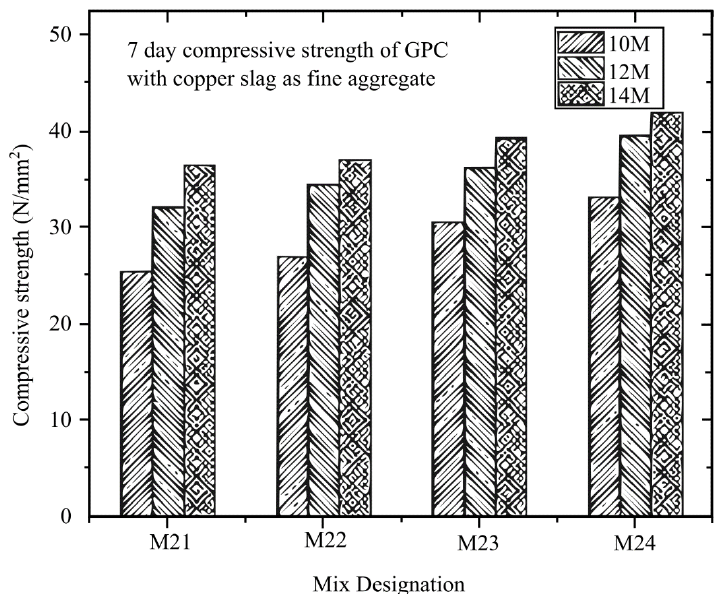
Figure 15. Different molarities in the mix design of GPC and copper slag at 7 days [145].